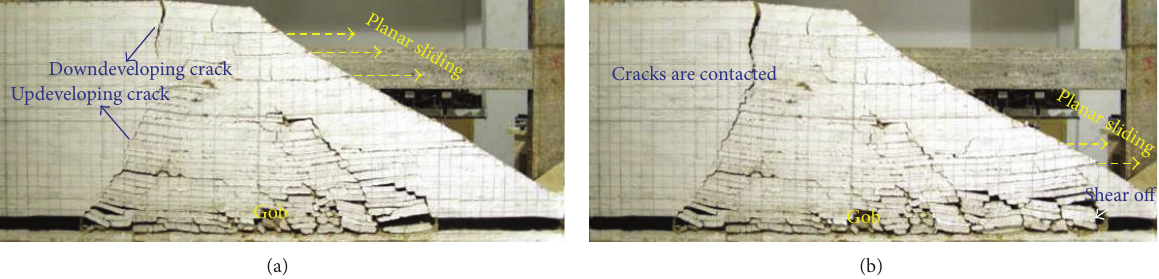
Figure 5: The overburden movement in response to underground mining in downslope direction. (a) The slope slid obviously layer by layer. (b) The roof sheared off along the coalface.